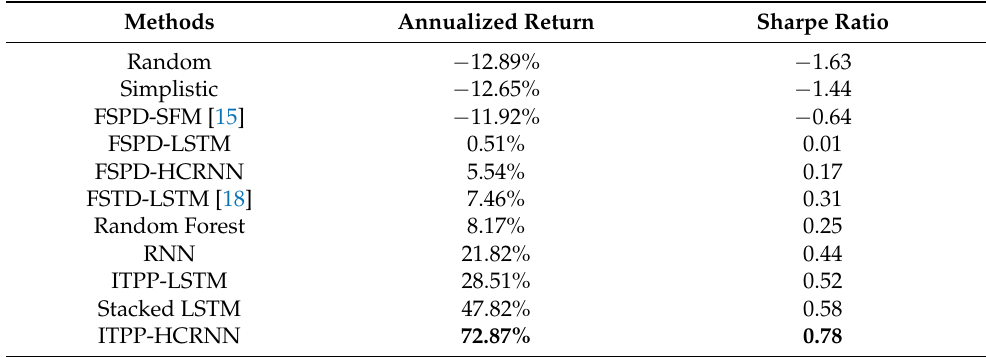
Figure 7. The cumulative profit curve for each method over four years. Table 4. Comparison results for each method. The best results are in bold. FSPD: forecasting stock prices directly; FSTD: forecasting stock trends directly; SFM: state frequency memory; RNN: recurrent neural network; ITPP: important trading point prediction; LSTM: long short-term memory; HCRNN: hybrid convolutional recurrent neural